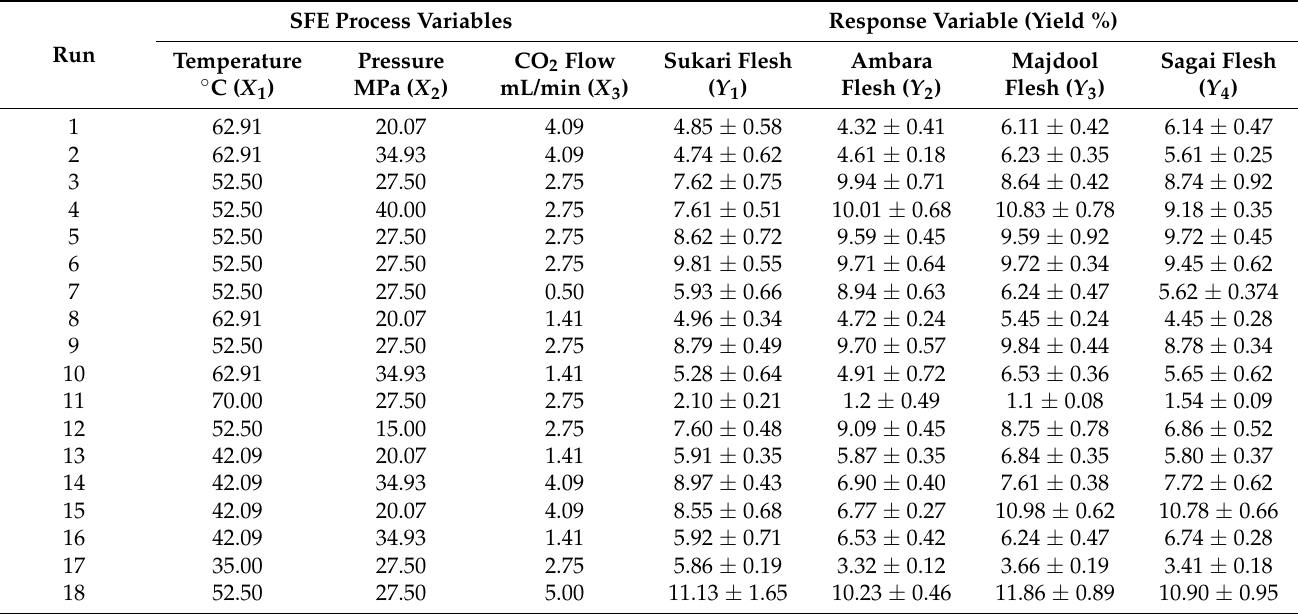
Table 1. Date flesh extraction experimental design for supercritical fluid extraction